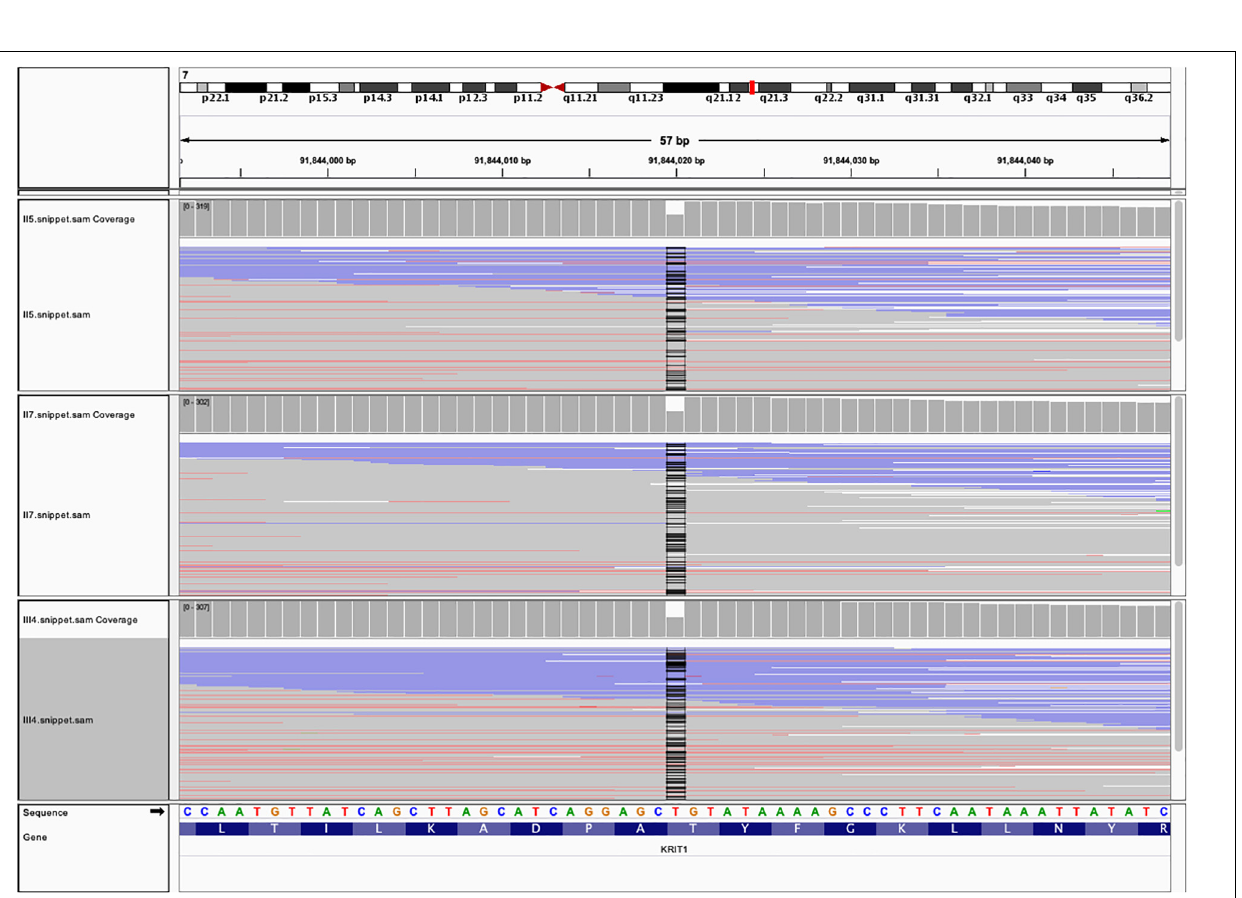
FIGURE 4 | The whole exome sequencing (WES) data from the three family members with FCCMs. A chromosome ideogram with the genetic location of CCM1 (red line) was shown in the upper part [(hg19) chr7:92,198,968 – 92,246,100]. Read alignment of the hybrid capture WES data from the proband III4, her mother II5 and her uncle II7 showed a part of exon 15of CCM1 gene. The coverage plot indicated that no read was found at position of chr7:91,844,020 (black line).